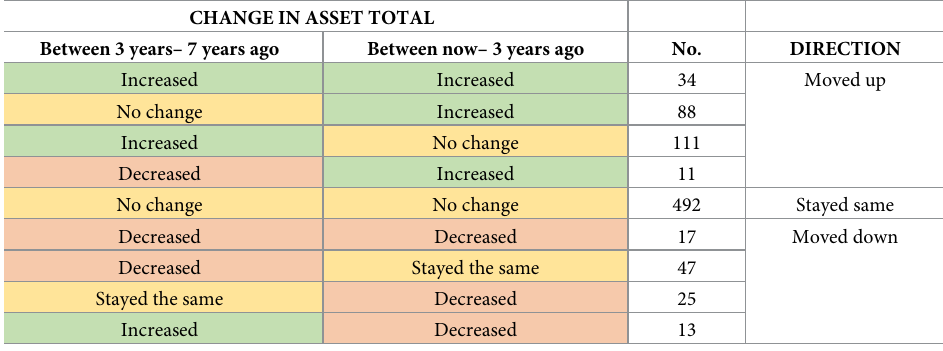
Table 1. Poverty trajectory identification from changes in asset